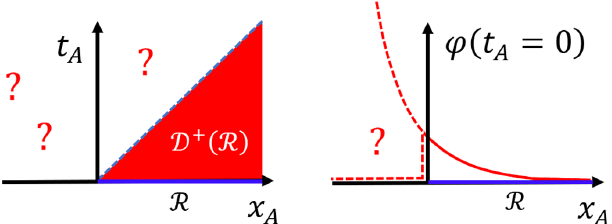
< 0 (at A 0 Þ and φ ⋆ ð t 0 Þ¼ A ¼ A ¼